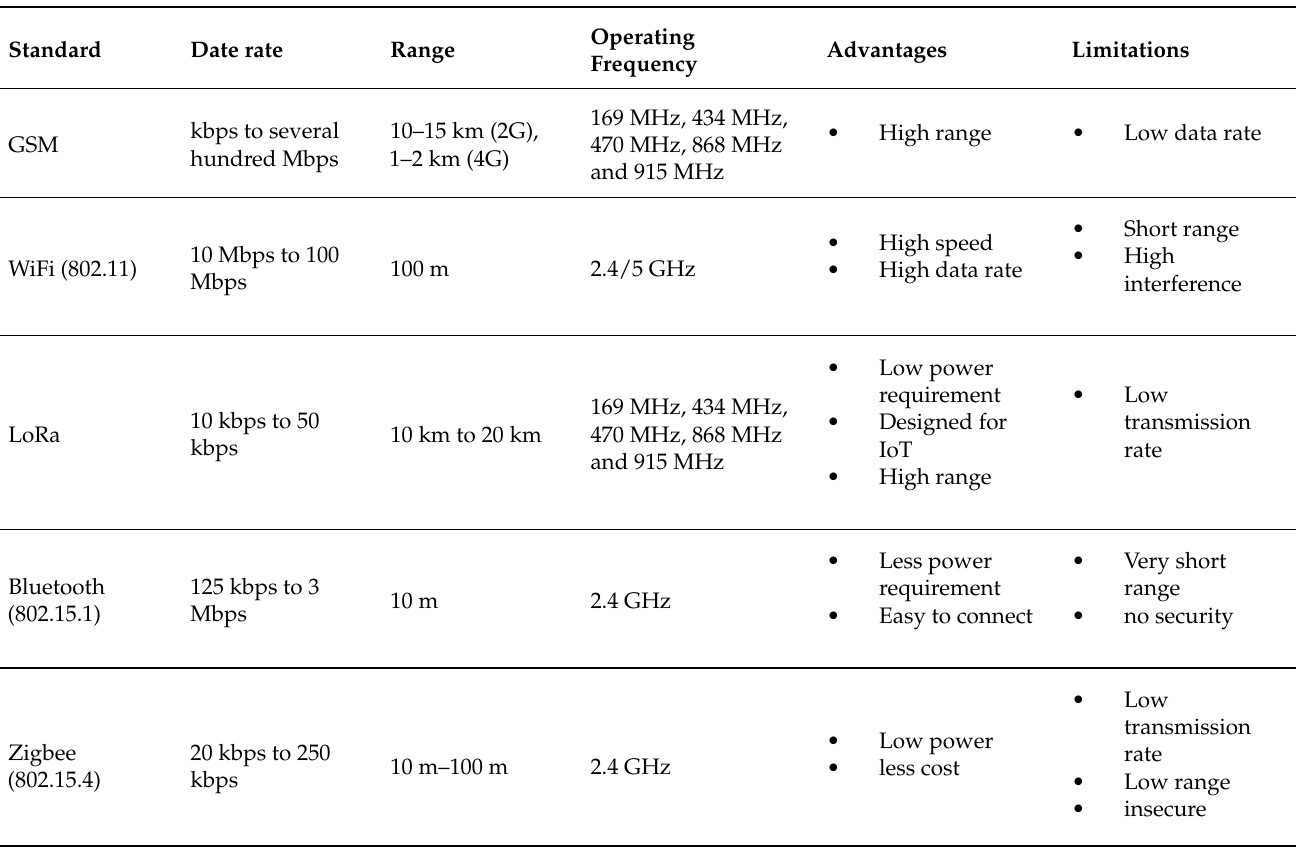
Table 4. Various communication techniques that are useful in AQM sensor node